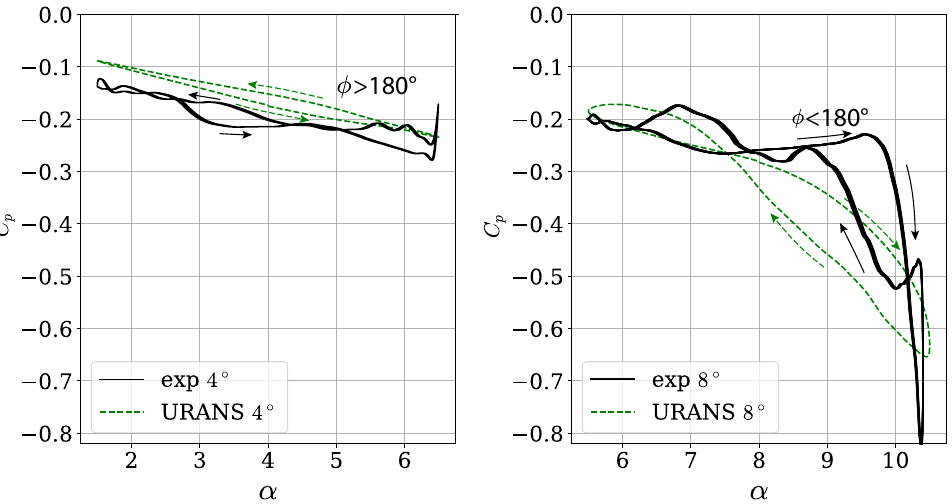
Figure 10. Hysteresis of unsteady pressure at 20% chord for 2.5 ◦ pitching amplitude around mean incidence α 0 = 4 ◦ and α 0 = 8 ◦ for k =